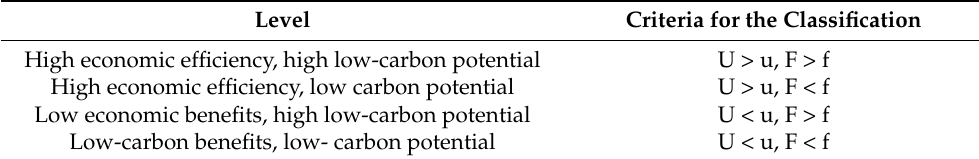
Table 12. Criteria for the classification of carbon emission economic benefits and low-carbon develop- ment